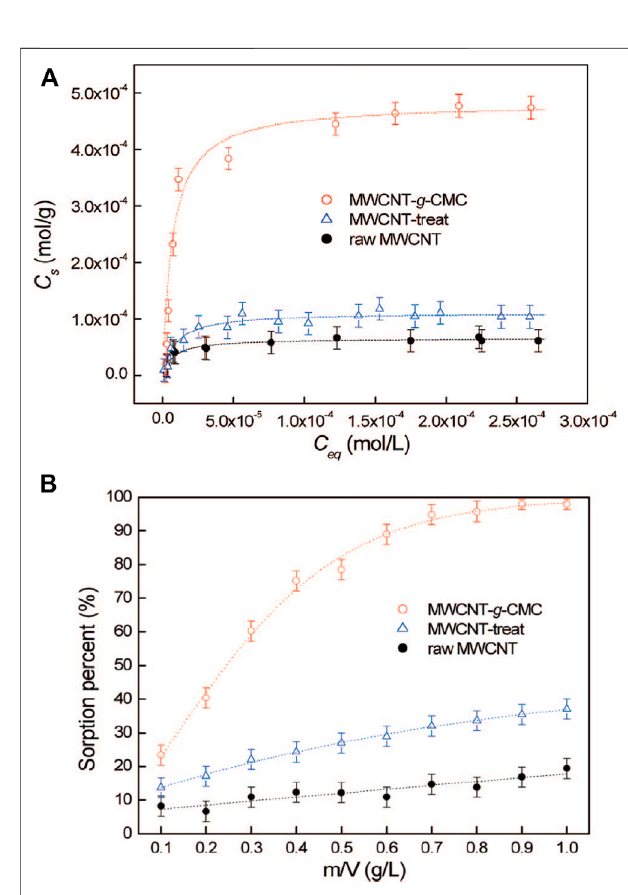
FIGURE 3 | Sorption isotherms (A) and effect of sorbent content (B) on theremovalofUO 2 2+ fromsolutiononrawMWCNT,onMWCNT-treat,andon MWCNT- g -CMC. T = 25 ± 2 ° C, equilibrium time 24 h, pH = 5.0 ± 0.1, C [NaClO 4 ]= 1.0×10 ‒ 2 mol/L (A) m/V = 0.4 g/L, (B) C[UO 22+ ] (initial) = 2.00 × 10 ‒ 4 mol/L (Shao et al.,